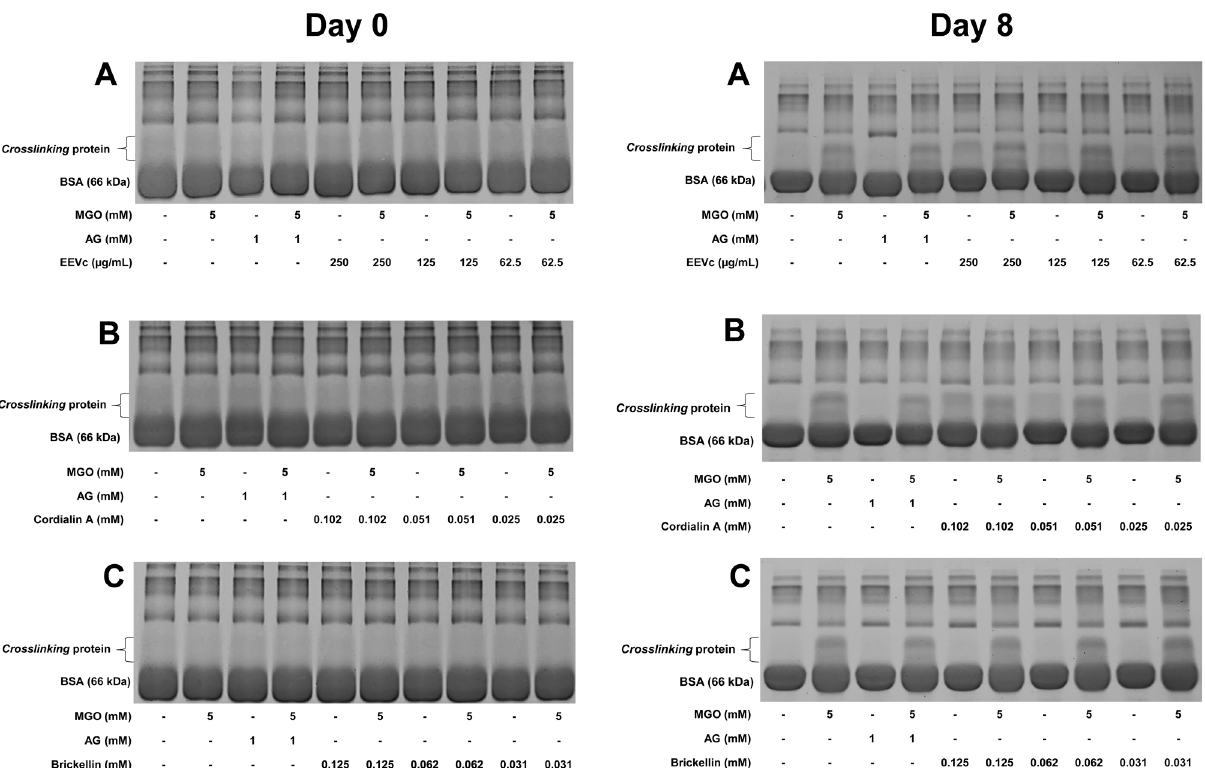
Figure 5. Effects of ( A ) EEVc, ( B ) cordialin A and ( C ) brickellin on protein crosslinking formation on day 0 and day 8 in an in vitro protein glycation model system using BSA and MGO. BSA: bovine serum albumin; MGO: methylglyoxal; AG: aminoguanidine; EEVc: ethanolic extract of V. curassavica .